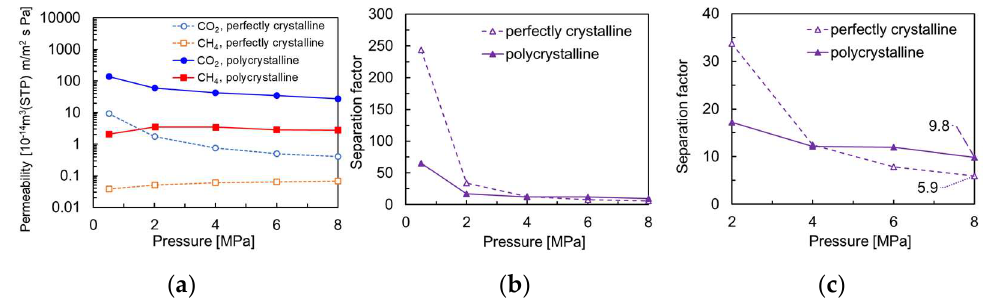
Figure 8. Comparison of NEMD results on the polycrystalline and perfectly crystalline membrane models at different pressure conditions. ( a ) Permeability, ( b ) separation factor, ( c ) enlarged ( b ) at high pressure.